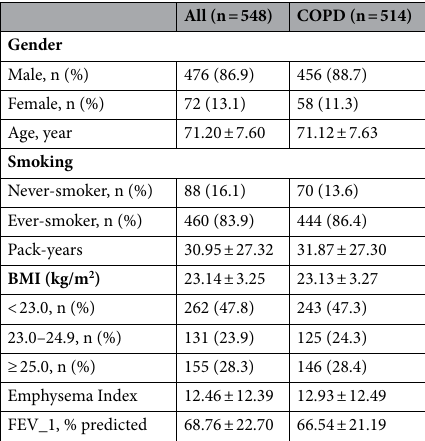
Table 1. Characteristics of subjects included in Genome-Wide Association Study. Data are mean ± SD for continuous variables and n (%) for categorical